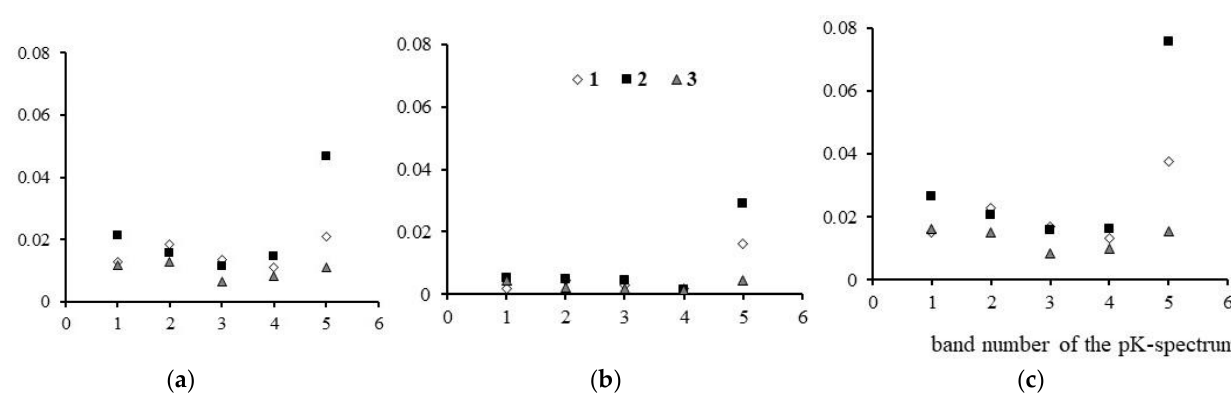
Figure 6. The number of acid groups ( n / m , mmol∙kg −1 ) of water extracts ( a ), scour water ( b ), and their total amount ( c ) in the samples of organogenic horizons in the p K intervals: 1 : Distric Albic Retisol (Loamic); 2 : Eutric Albic Retisol (Loamic); and 3 : Distric Gleyic Retisol (Loamic).